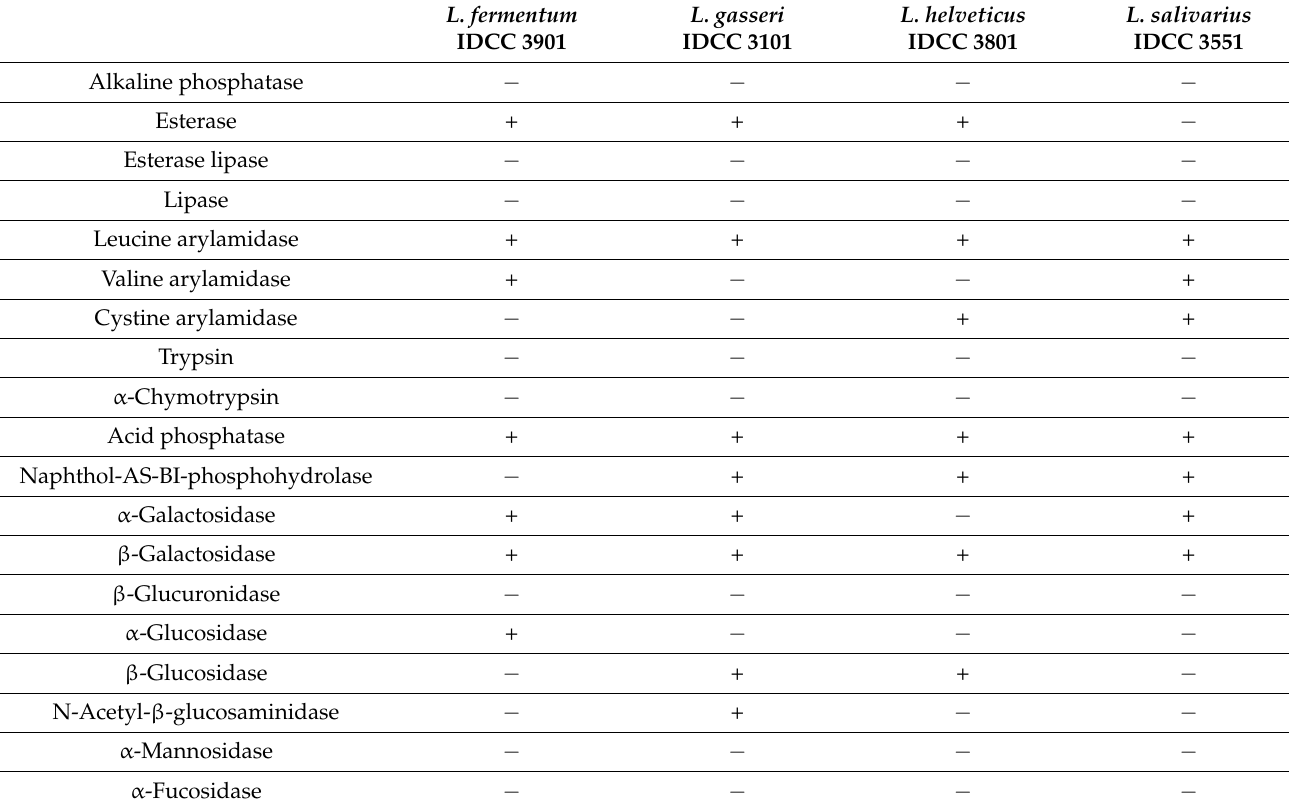
Table 5. Enzymatic activities of four Lactobacillus species.